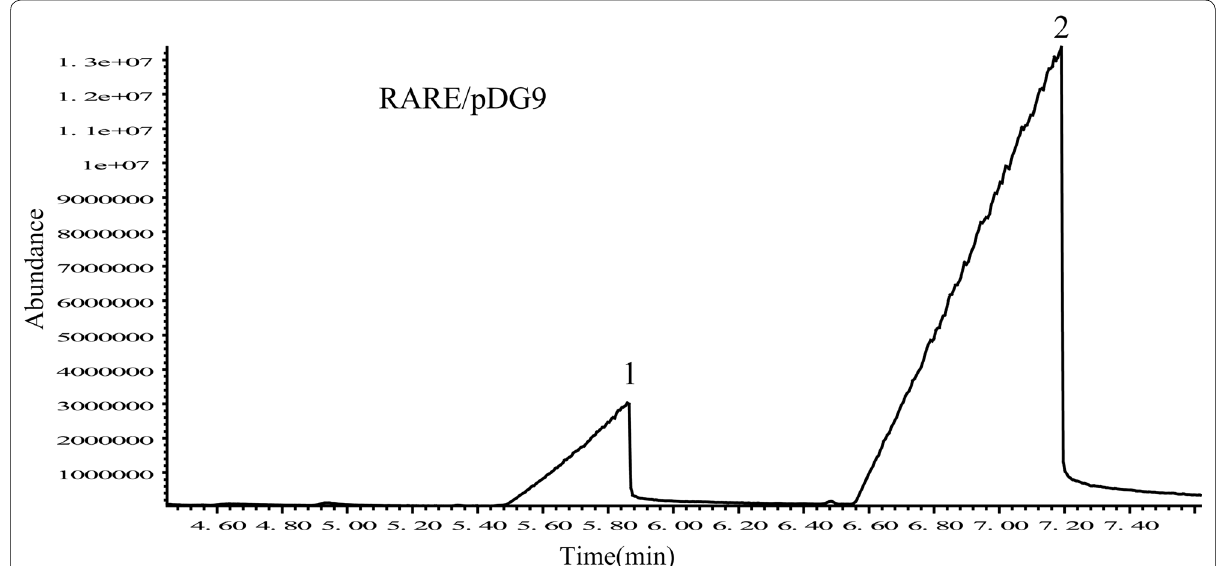
Fig. 3 The GC/MS result of PAA from the extract of the recombinant strain RARE/pDG9 in shake flasks for 28 h. Identified substances: 1 benzoic acid (used as internal standard, 100 mg/L); 2 phenylacetic acid